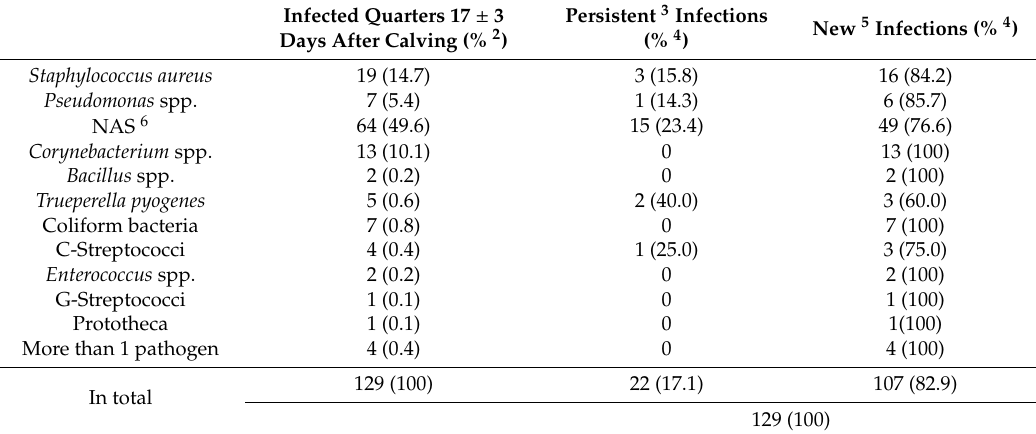
Table 4. Cause of infections existing at day 17 ± 3 postpartum 1